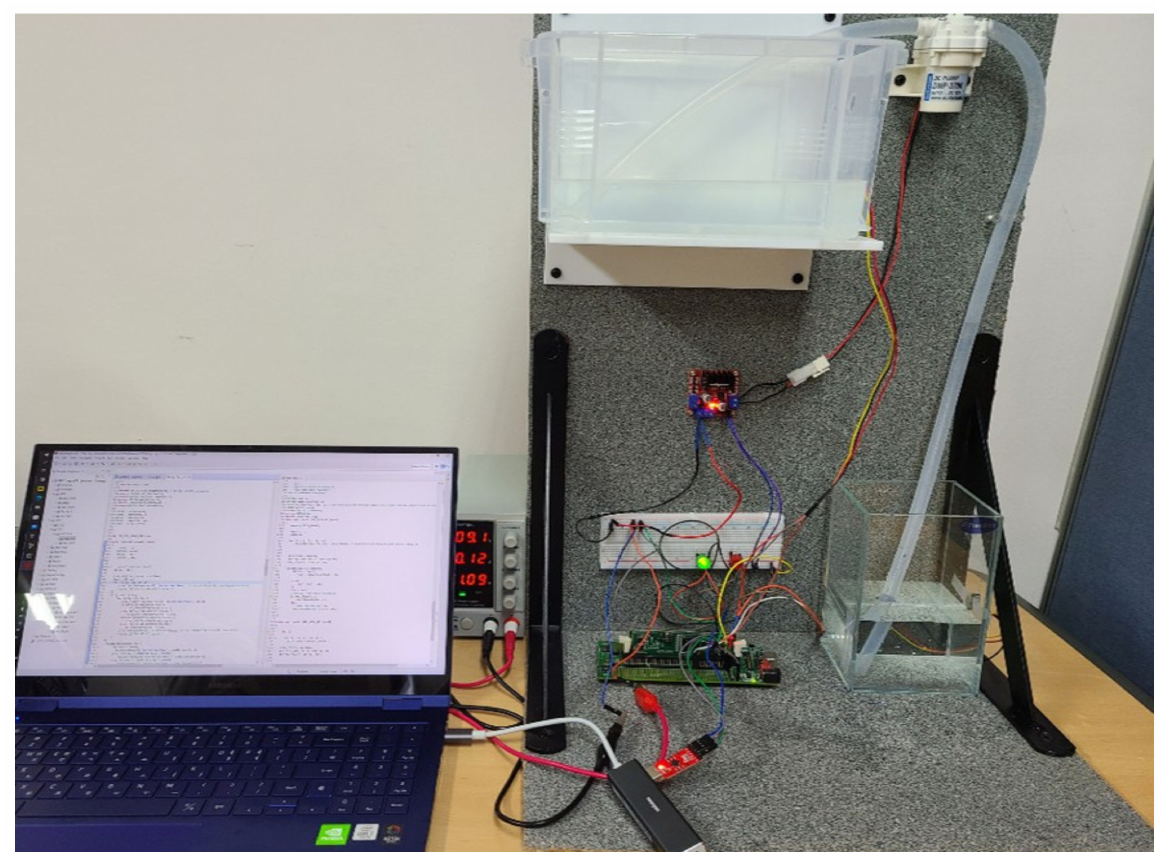
Figure 5. Water tank testbed.